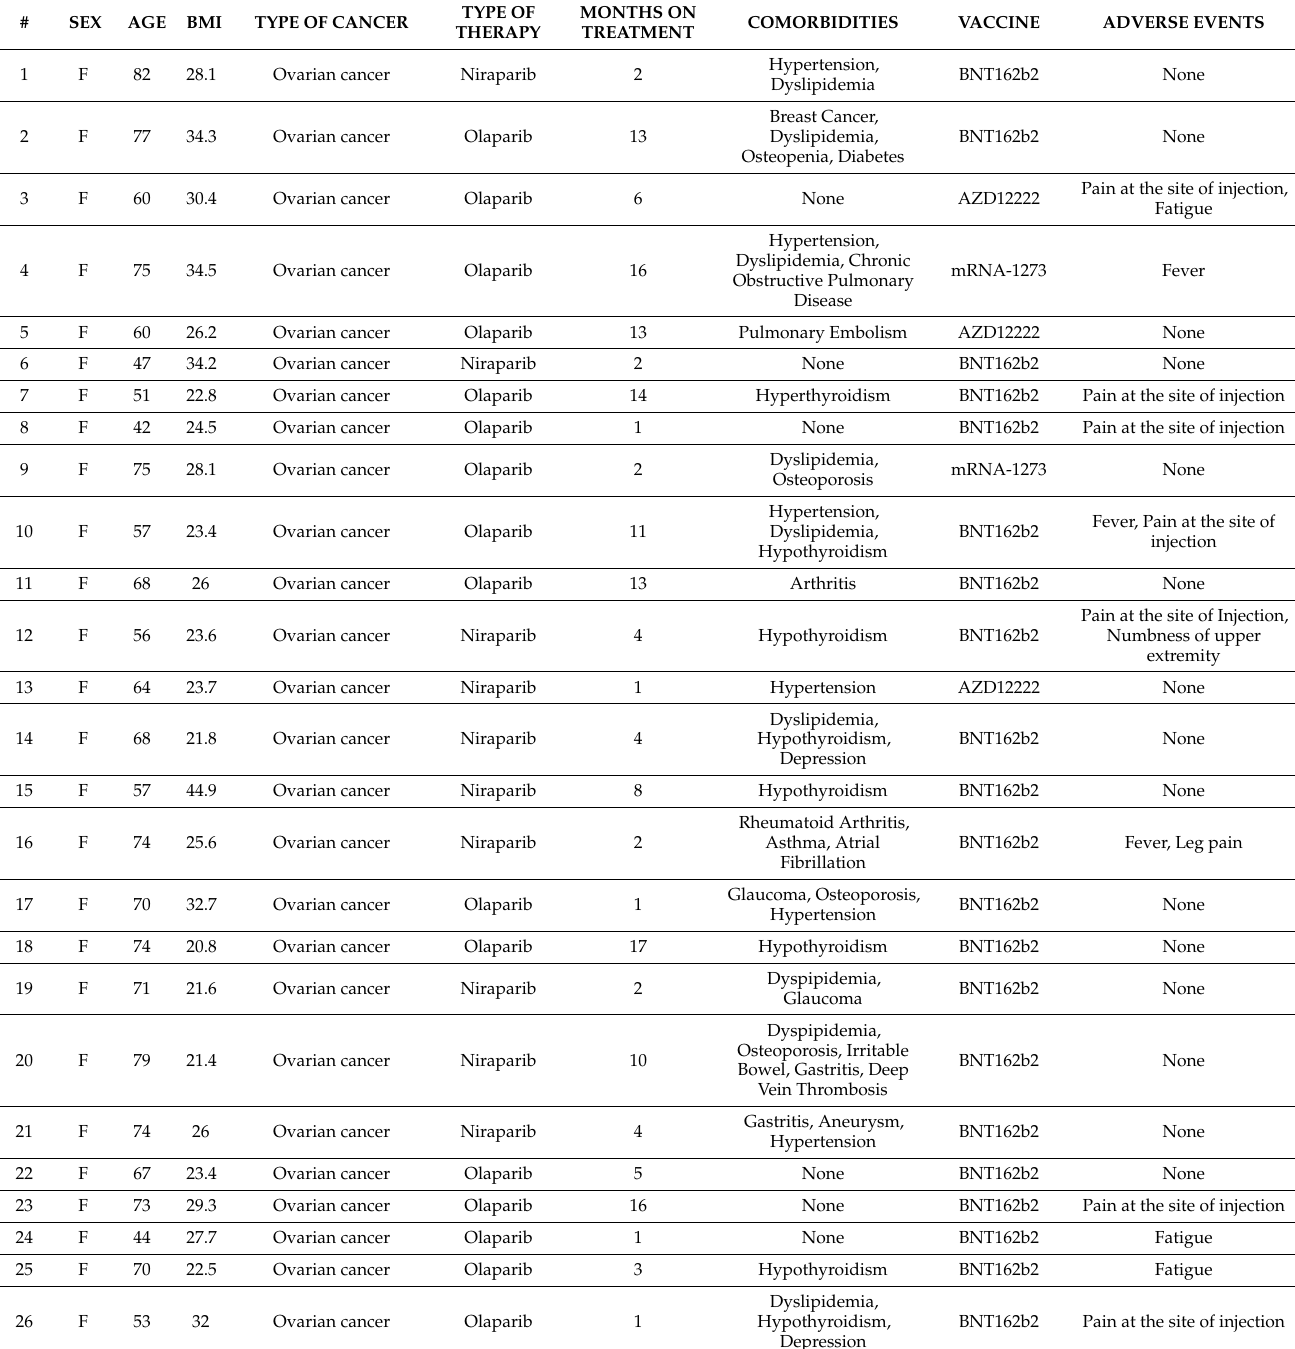
Table 1. Patient